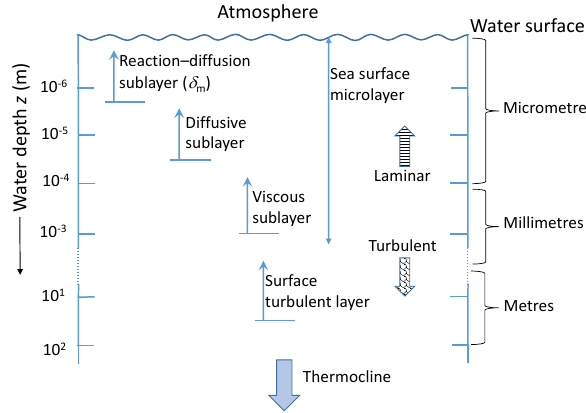
Figure 1. Idealised representation of the vertical structure of the top few metres of sea water. The depth of the reaction–diffusion sublayer ( δ m ) will vary according to the chemical reactivity of the ocean water to